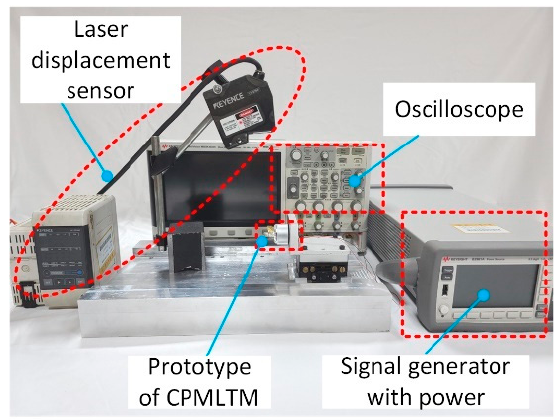
Figure 19. The angular test rig.